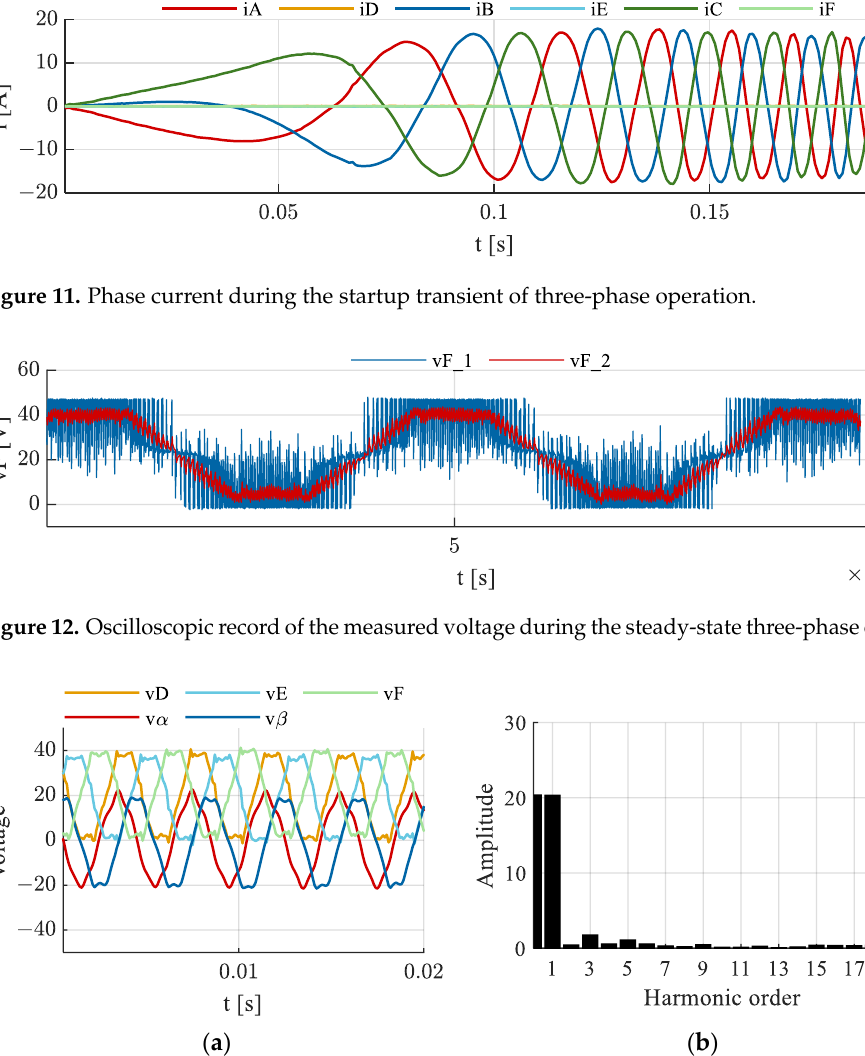
Figure 10. Measured voltages during the steady-state six-phase operation: ( a ) measured phase volt- ages and their transformed α–β components; ( b ) frequency spectrum of the measured voltage vF.